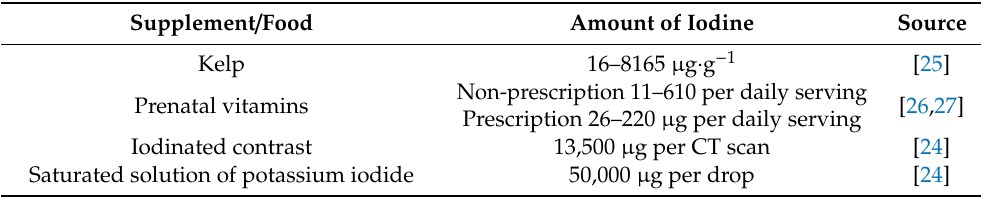
Table 4. Sources of excess iodine intake with potential thyroid disfunction